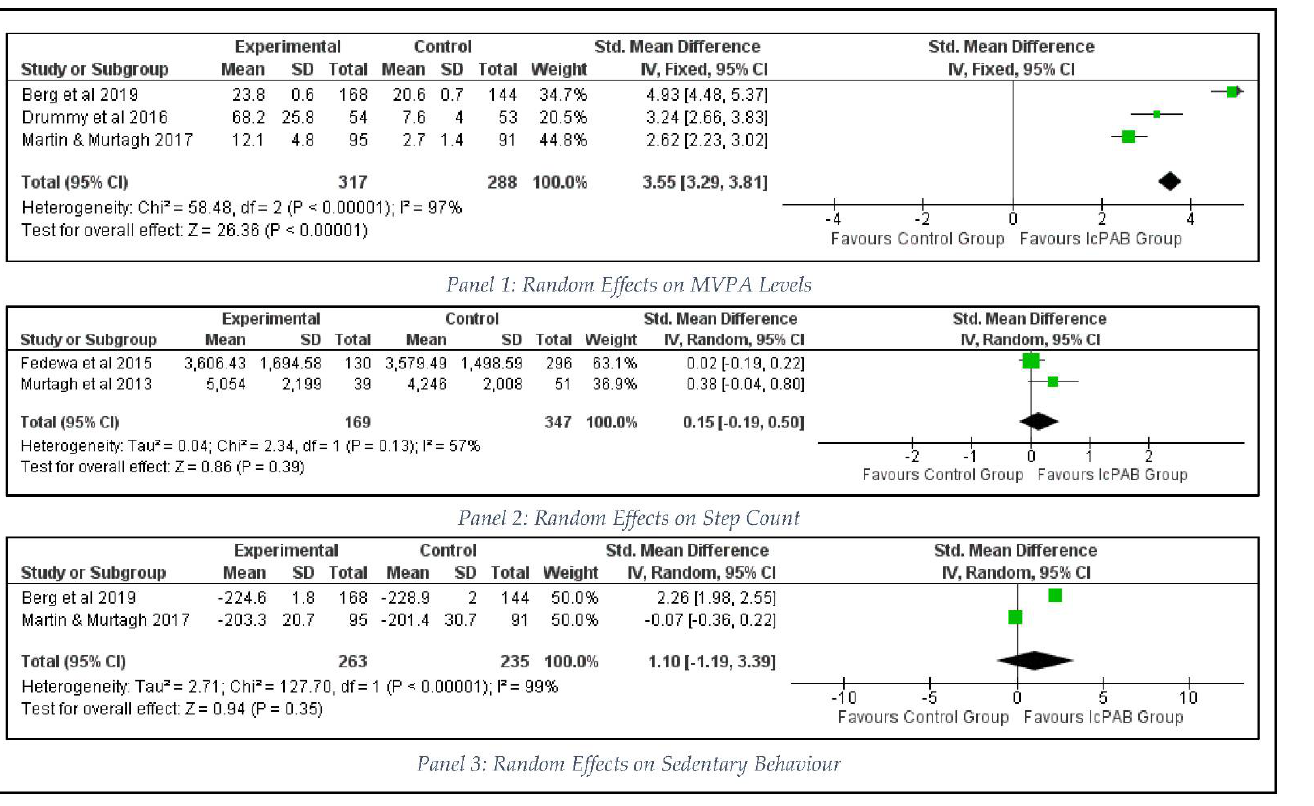
Figure 4. Effects of IcPAB on Health Behaviour Outcomes.